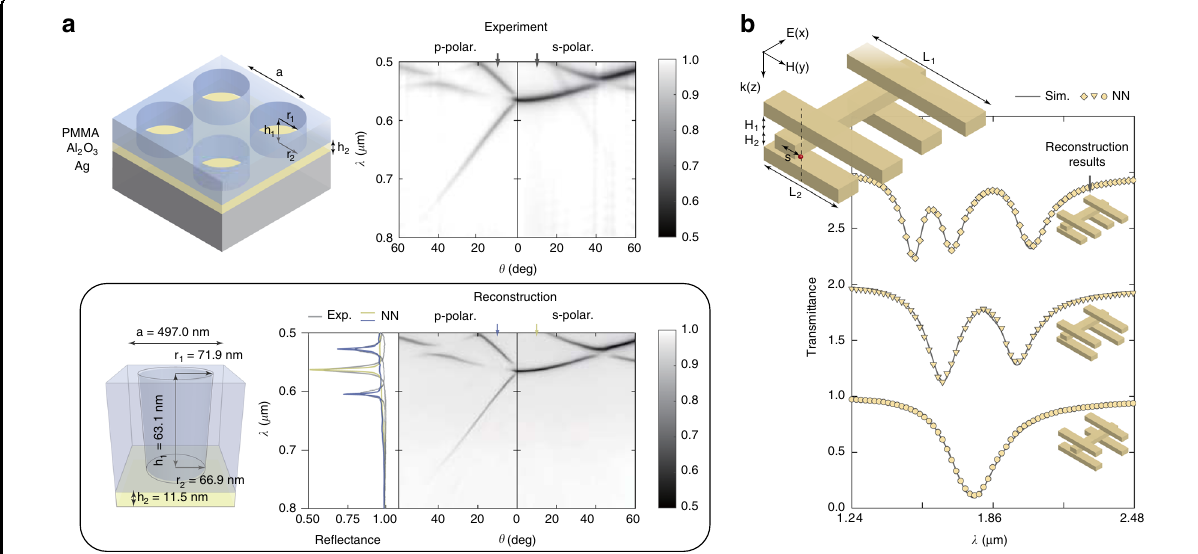
Fig. 5 Reconstruction results of 2D grating and 3D plasmon ruler. a (top left panel) 2D grating etched in polymethyl methacrylate layer on an aluminum oxide layer and a silver substrate. 2D grating is modeled with fi ve parameters: a, r 1 , r 2 , h 1 and h 2 . (top right panel) Measured photonic dispersion patterns of 2D grating with p and s-polarized incident light. (low panel) Corresponding reconstructed parameters of 2D grating. Generated photonic dispersion using forward-mapping NN with reconstructed parameters and detailed slice comparison between experimental and generated dispersion at 10°. b 3D plasmon ruler is modeled with fi ve parameters: L 1 , L 2 , s, H 1 , H 2 . The spectra are shifted upward for clarity. Gray lines are simulated transmittance spectra, which are input into the forward-mapping algorithm for reconstruction. Plasmon-ruler structure diagrams next to the spectra are reconstructed results. Spectra generated by forward-mapping NN are plotted with golden